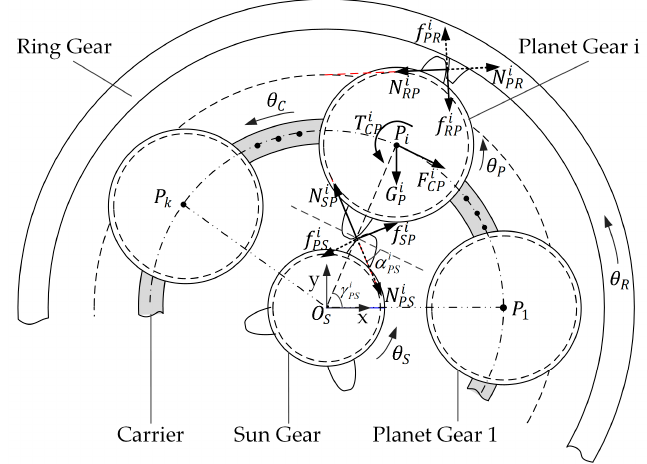
Figure 2. Force analysis of the planetary gear set.